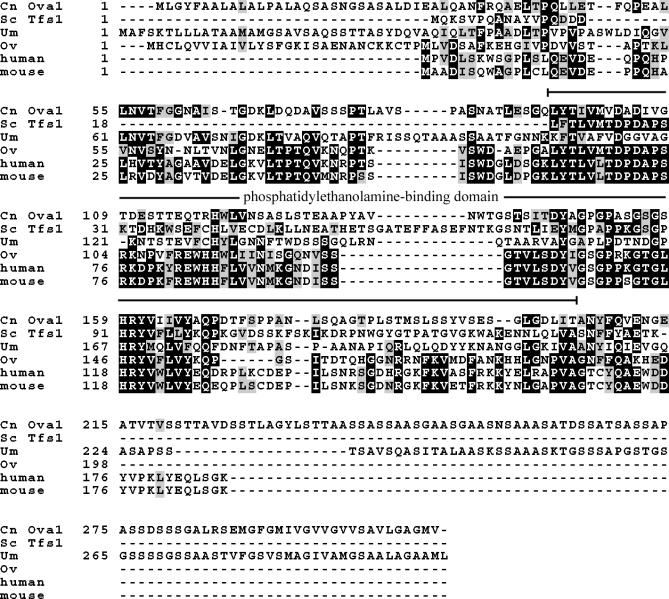
Multiple Alignment of Ova1 with TFS1 and Other PEBP Family MembersThe amino acid sequence alignment was performed with Clustal W (http://www.ch.embnet.org); identical residues are boxed in black and similar residues are shown in gray. The phosphatidylethanolamine-binding domain is indicated by a bold arrow spanning residues 91–204 of Ova1. Cn, C. neoformans var. grubii; Ov, Onchocerca volvulus; Sc, Saccharomyces cerevisiae; Um, Ustilago maydis.